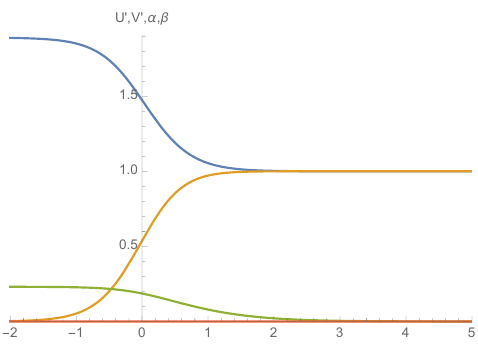
Figure 1 . A domain wall solution of U 0 (blue), V 0 (orange), (cid:11) (green), and (cid:12) (red). with a